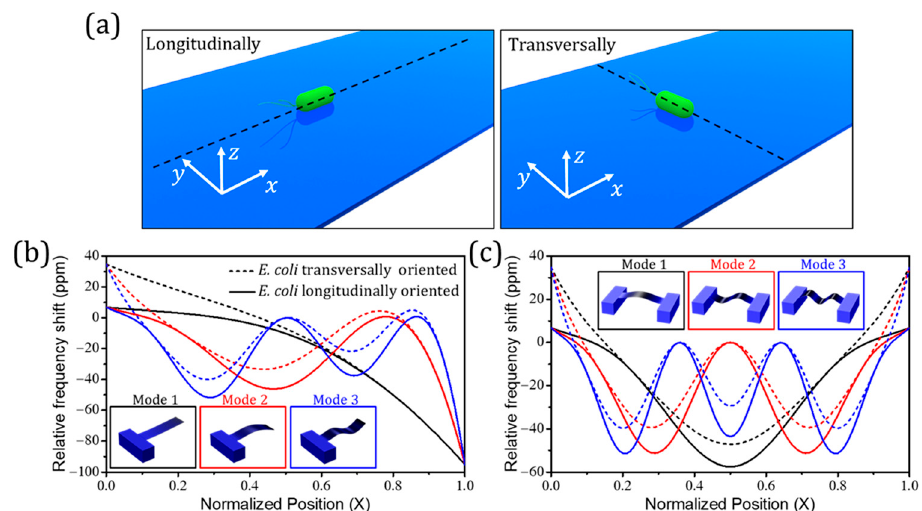
Figure 5. ( a ) Schematic depiction of a bacterium adsorbed longitudinally and transversally oriented on a resonator. ( b , c ) Relative frequency shift produced by the adsorption of a typical E. coli bacterium on a silicon nitride cantilever and a doubly clamped beam of 200 × 20 × 0.6 µm for the first three flexural modes. It can be seen that, because of the edge effects of the bacterium, the stiffness effect is considerably smaller when the bacterium is transversally oriented.